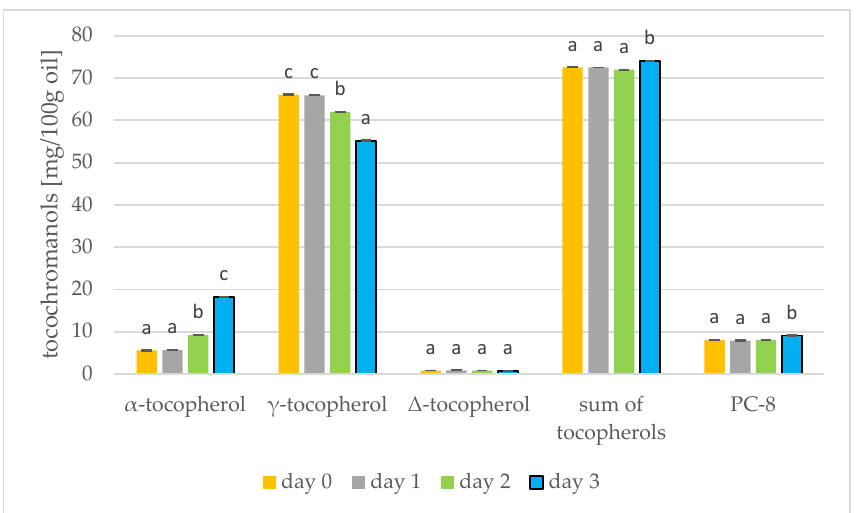
Figure 5. Level of tocochromanols [mg/100 g oil] during mustard seed germination (days 0, 1, 2, 3) PC ‐ 8—plastochromanol ‐ 8 (values are means ± SD from three experiments. Values with different letters are significantly different ( p < 0.05)).